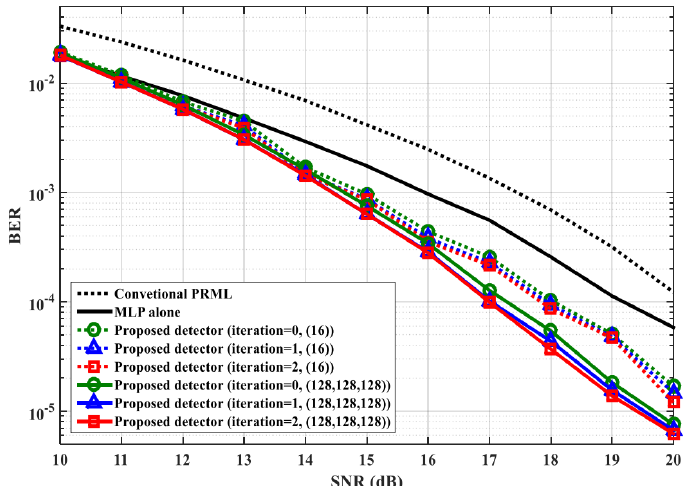
Figure 4. BER performance comparisons among conventional partial response maximum likelihood (PRML) detector, MLP alone, and proposed detector based on signal-to-noise ratio (SNR) at track misregistration (TMR) of